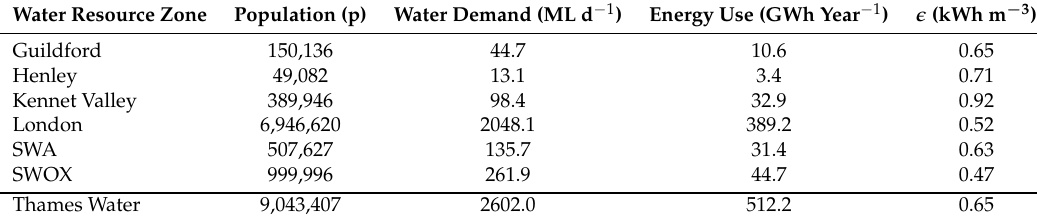
Table 1. Summary statistics related to the water supply system for each Water Resource Zone (WRZ) as of 2014. Energy use and intensity were calculated in this study, whereas population and water demand were obtained from Thames Water [39]. The final row shows a sum for the entire Thames Water system with the exception of the (cid:101) column, where a mean value is